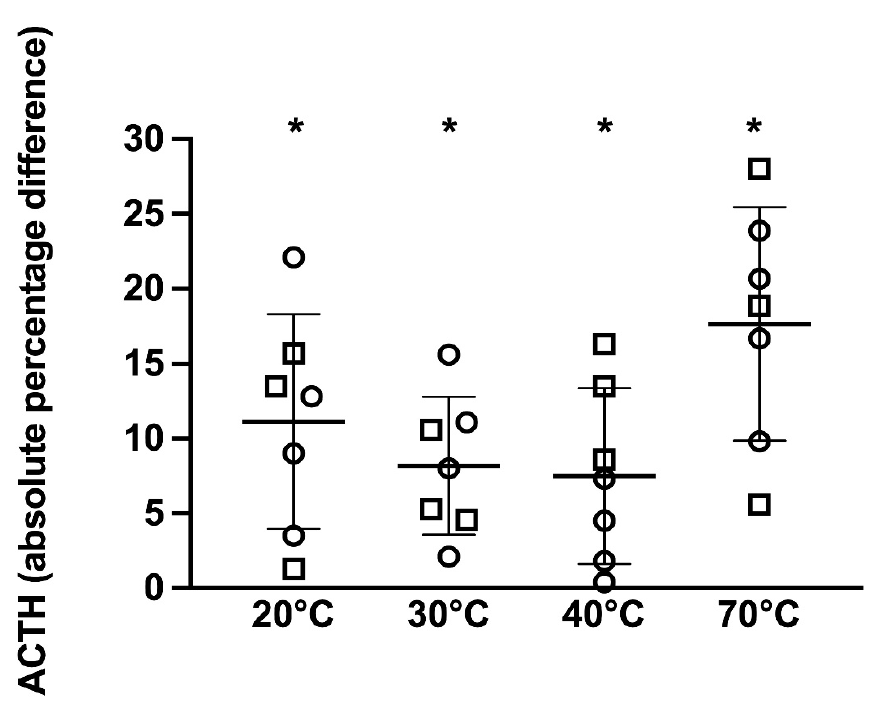
Figure 4. ACTH concentrations presented as the absolute percentage change from the reference sample in samples kept at 4 (reference sample), 20, 30, 40, and 70 °C in 7 non-PPID horses (hollow shapes) with mean ± standard deviation shown. Squares represent horses in which the basal ACTH concentration was determined and circles indicate horses in which the post-TRH stimulation ACTH concentration was determined. * p < 0.05 vs. 4 °C.